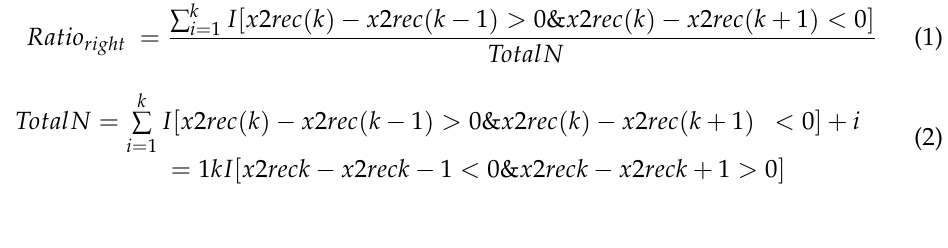
The prominent patterns of eye movements are classified as moving to the left eye movements, right eye movements, and blinking. To simplify the complexity of the EOG measuring device and therefore improve the comfort when wearing, this paper designs a single-channel device with three electrodes. Electrodes are not placed on the upper and lower part of the eye for testing, so the blink signal is not detected. To extract the eye movement peak ratio feature, firstly, the baseline threshold THB is set and the signal is rectangular-sized (as shown in Figure 11). Then, use the differential thresholding algo- rithm to extract the peak and trough values of the eye movement signal. Finally, the ratio of the number of peaks and troughs to the number of points sampled is counted sepa- rately. As the eye movement peak ratio feature, this ratio is expressed in a physiological sense as the frequency of eye movements to the right and the frequency of eye movements to the left, respectively. Equations (1) and (2) show the calculation method.